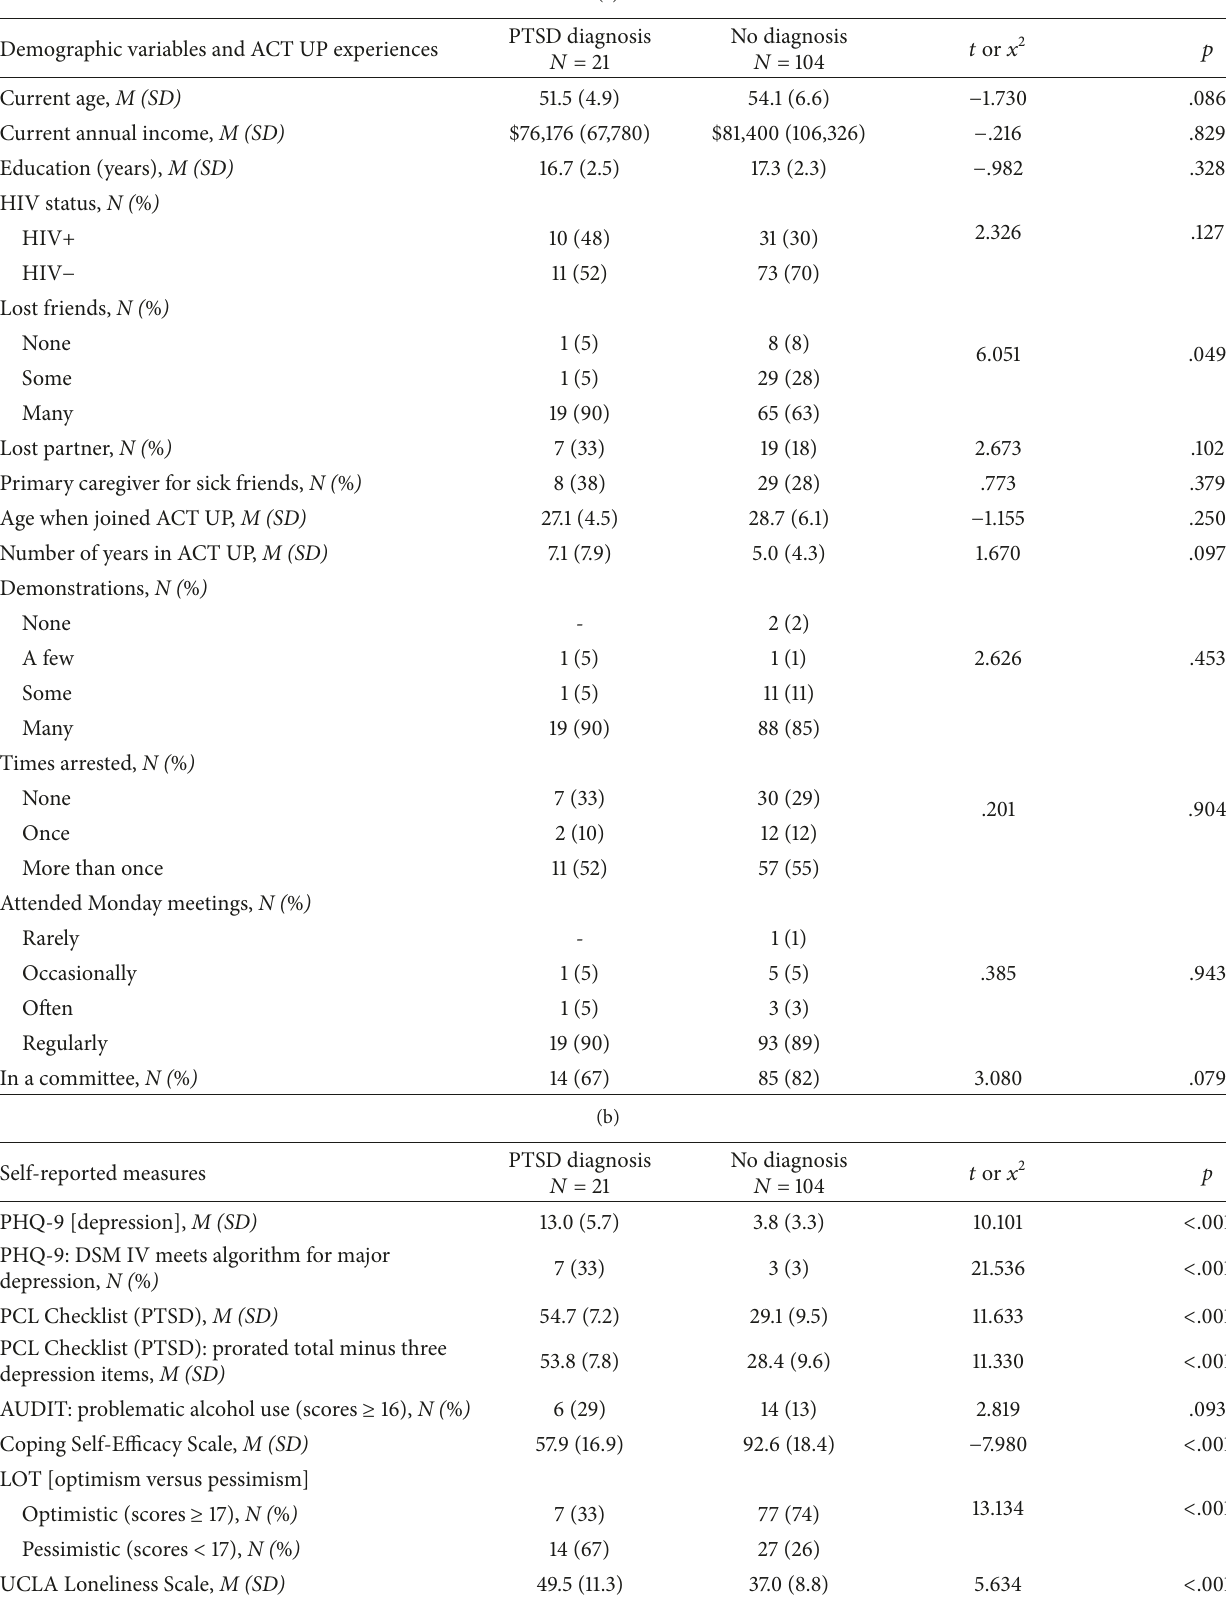
Table 3: Comparisons of ACT UP study participants with and without PTSD